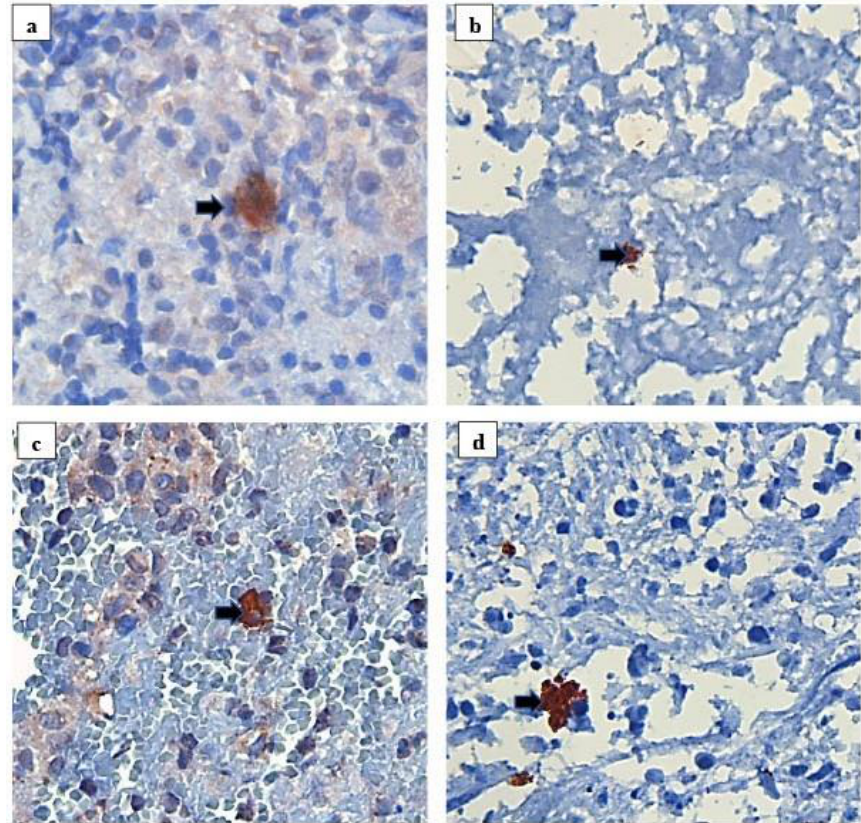
Figure 4. Immunohistochemistry with the new ( a , c ) and reference anti-MPT64 polyclonal antibody ( b , d ) on tissue sections from patients with tuberculosis lymph adenitis. Specific staining is seen as reddish-brown granular staining (arrow) located intracellularly in the lesions. The weak diffuse staining in a and c is non-specific staining.